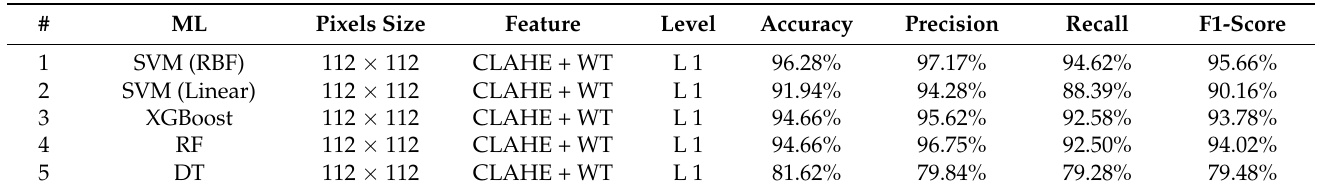
Table 7. Comparison of the results of the machine learning classifiers on version 1 of the dataset.